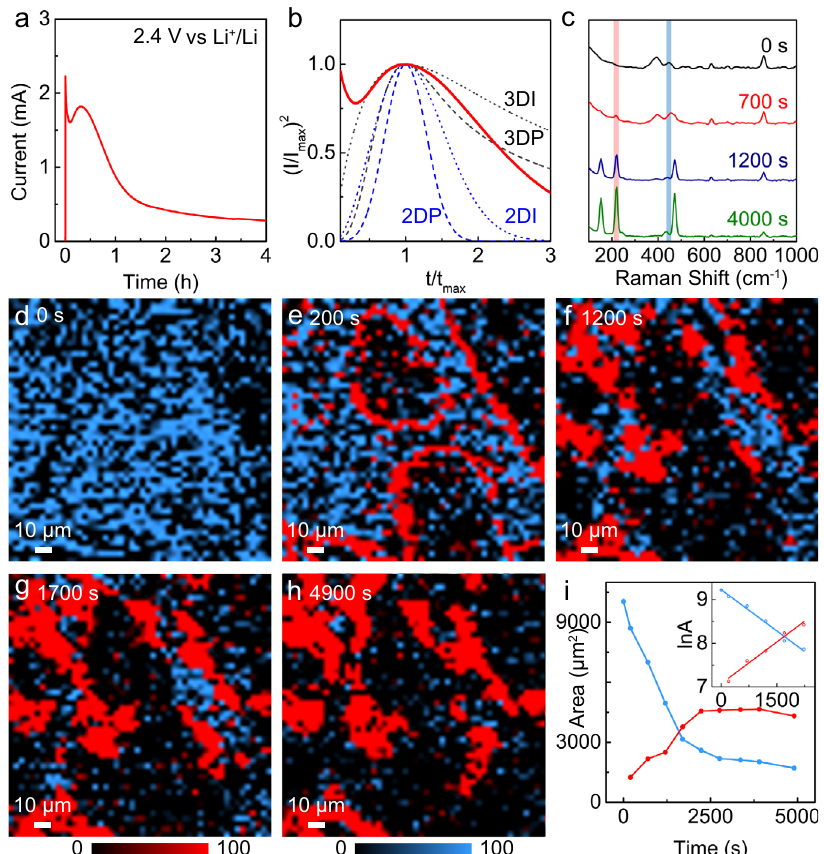
Fig. 3 | Oxidation of polysul fi des at 2.40V vs. Li + /Li. a Chronoamperometric current-time transient of polysul fi de oxidation at 2.40V (vs. Li + /Li). b Dimensionless plotof ( a ) according to SHand BFT models. Operando Raman( c ) spectra and ( d – h ) mapping images during oxidation. Blue: intermediate poly- sul fi des, Red: elemental sulfur, the color contrasts remain consistent in ( d – h ) for